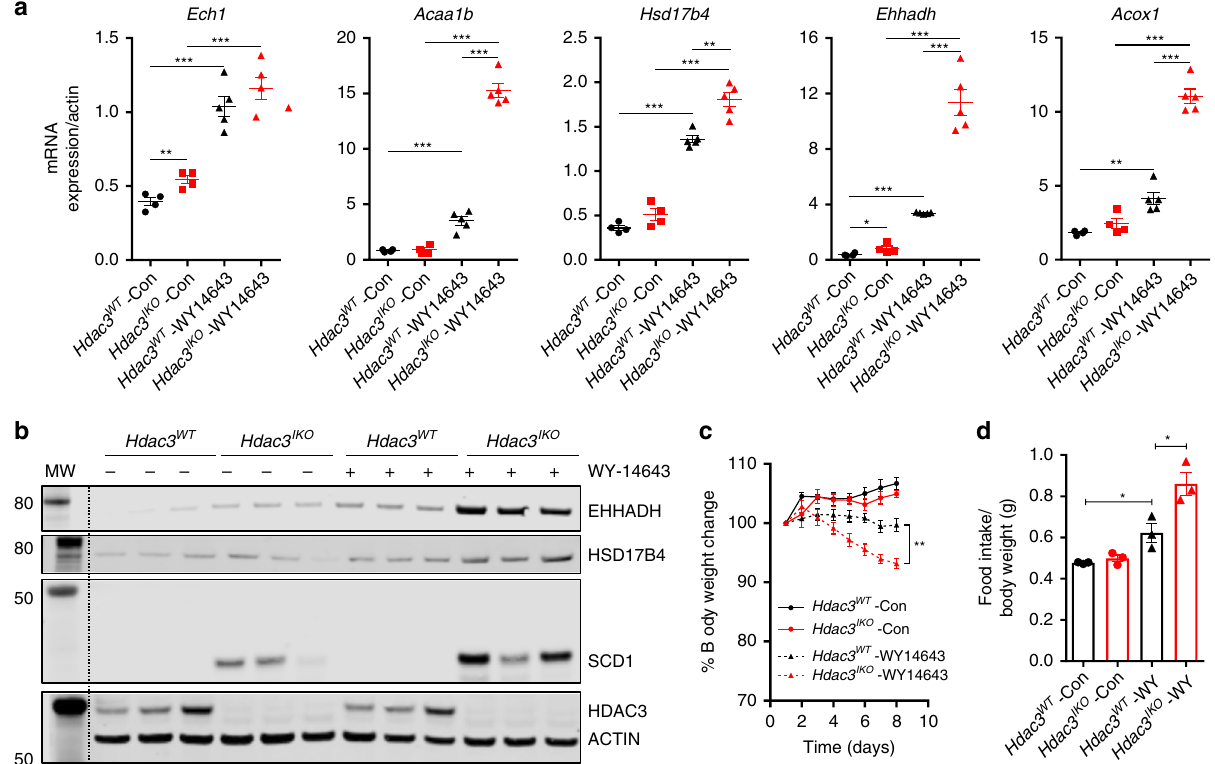
Fig. 7 HDAC3 deletion enhances sensitivity to PPAR agonists. The PPAR α agonist (WY-14643) preferentially induces fatty acid oxidation genes and reduces weight gain in Hdac3 IKO mice. a , b Hdac3 WT and Hdac3 IKO male mice 4 – 6 weeks of age were fed a standard chow diet supplemented with or without WY-14643 (WY) (0.1% w/w) for 24 h. Gene and protein expression changes in enterocytes isolated from the duodenum were determined by ( a ) qPCR and ( b ) western blot, respectively. Values shown are mean + SEM of n = 4 mice per treatment group, * P < 0.05, ** P < 0.005, unpaired t test. Western blots in ( b ) were performed on lysates isolated from three separate mice. c , d Hdac3 WT and Hdac3 IKO male mice (4 – 6 weeks of age) were fed a standard chow diet supplemented with or without WY-14643 (0.1% w/w) for 8 days, and ( c ) body weight and ( d ) average daily food intake measured over the fi nal 3 days of the experiment. Values shown are mean + SEM of n = 4 mice per genotype, * P < 0.05, ** P < 0.005, unpaired t test.